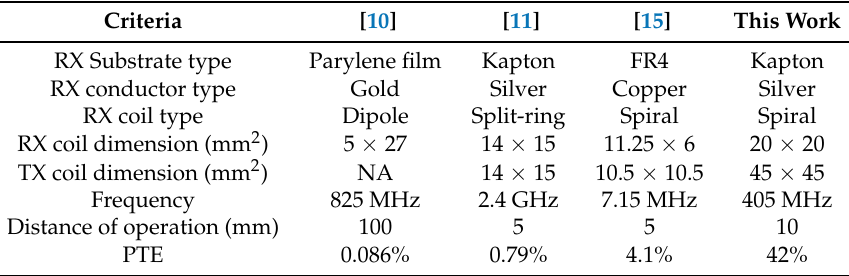
Table 3. Comparison with the state-of-the-art works.